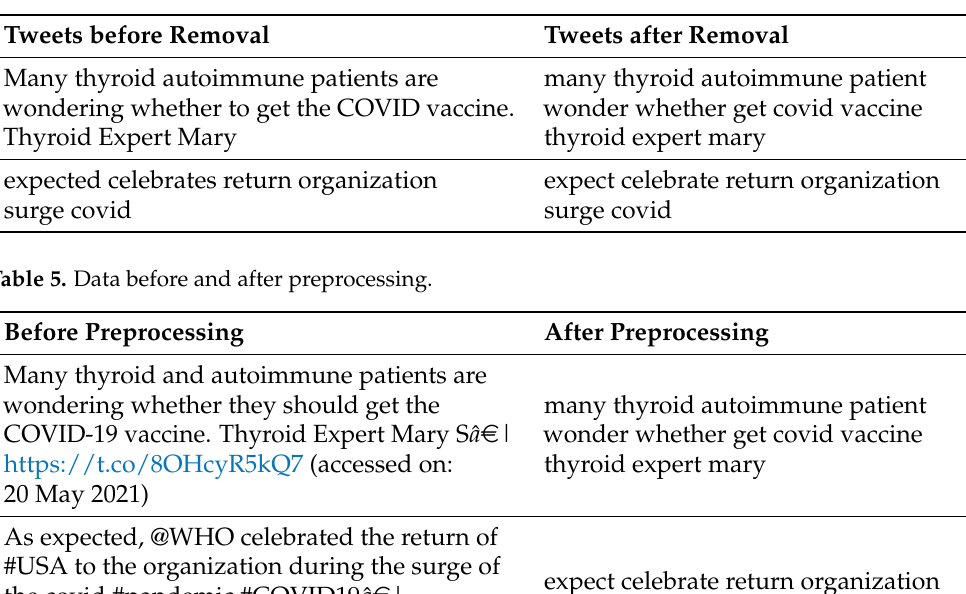
Table 4. Data after Lower case conversion, stemming, and lemmatization.